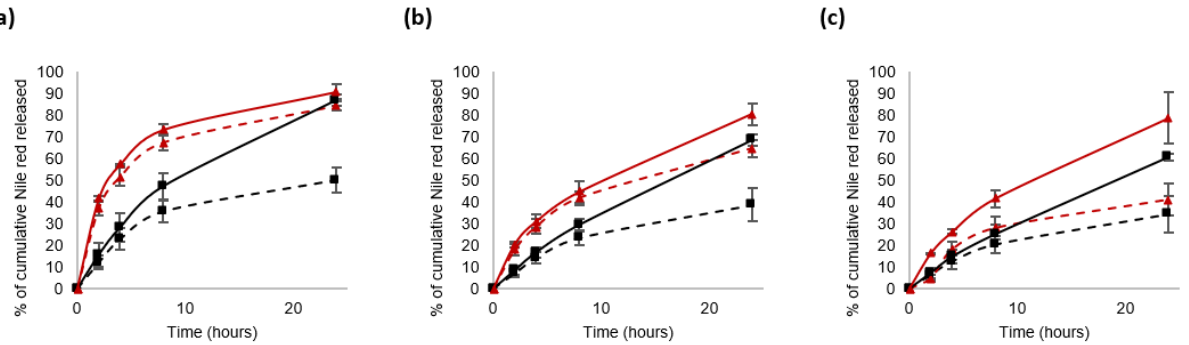
Figure 7. In vitro release of Nile red from the nanocarriers at 37 °C in water. The blends were used at 4 mg/mL ( a ), 10 mg/mL ( b ) or 16 mg/mL ( c ). The curves are encoded as follows: blend 1 (black square) or blend 3 (red triangle); without GSH (dashed lines) and in the presence of 10 mM GSH (continuous lines).